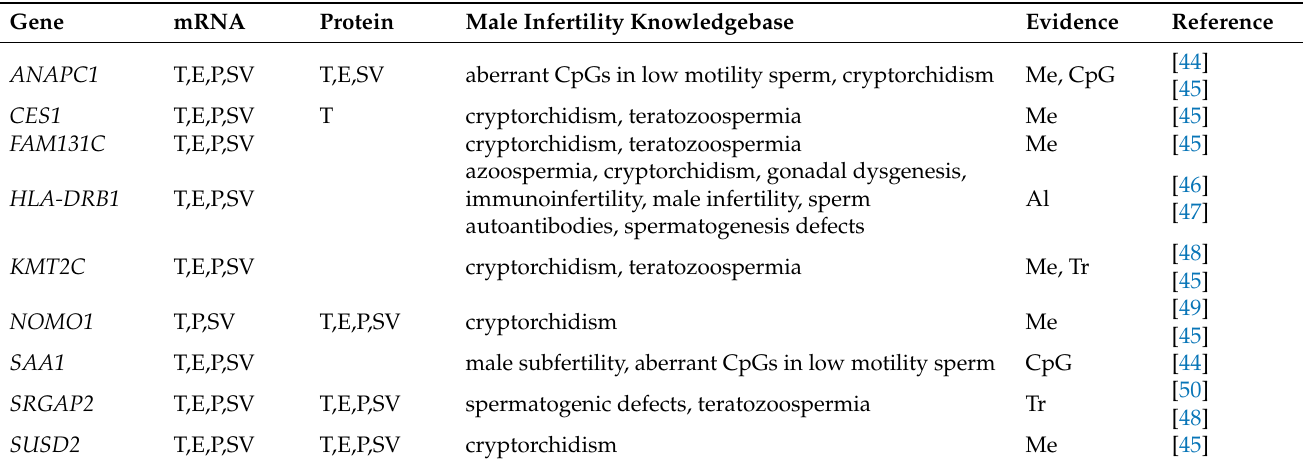
Table 3. Evidence suggesting fertility-relevance of genes harboring SNPs from present GWAS.